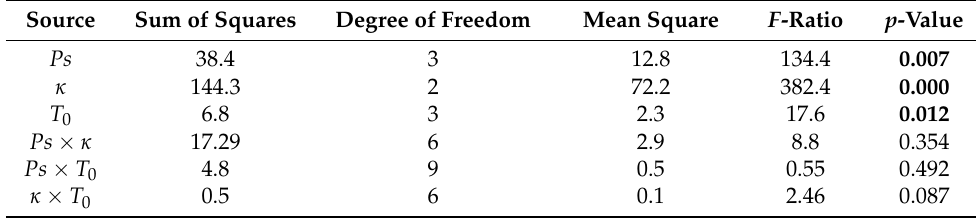
Table 1. ANOVA results of DMA parameter combinations.